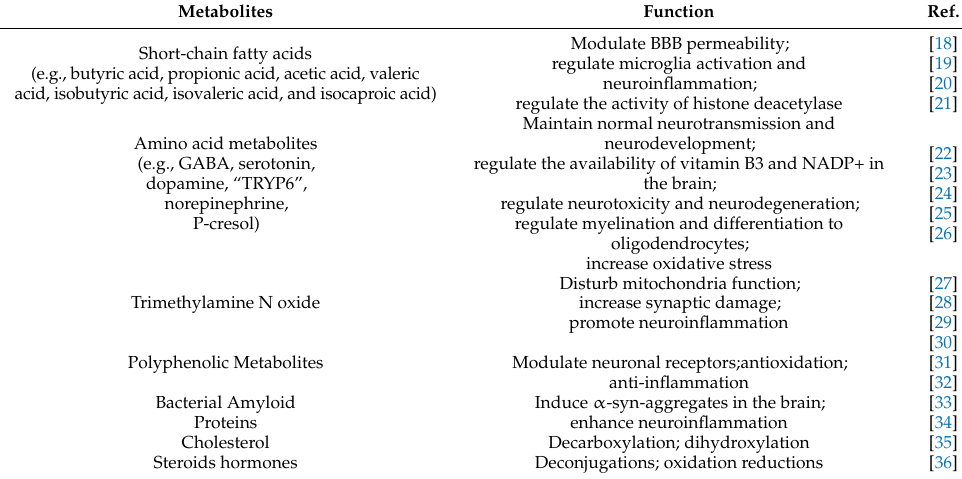
Table 1. Roles of gut microbial metabolites on brain development. Metabolites Function